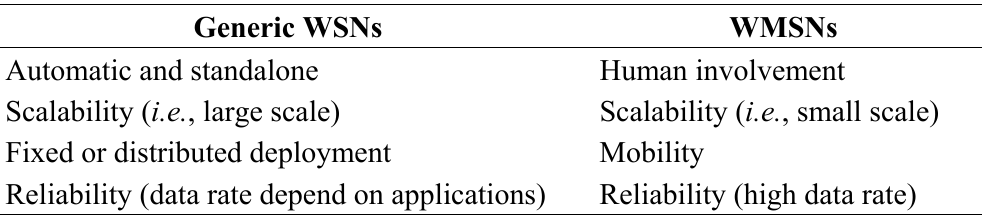
Table 1. Difference between generic WSN and